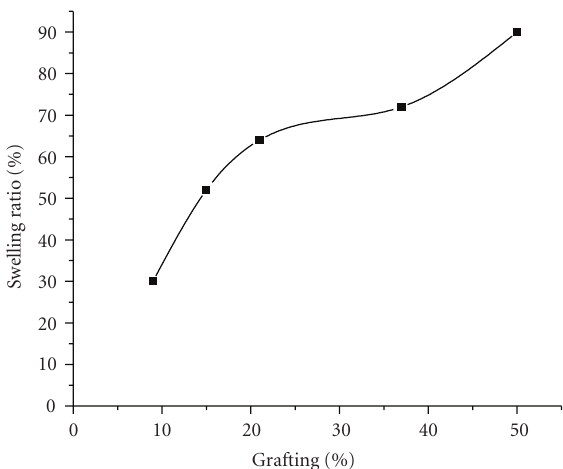
Figure 10: Swelling percentage of (IPP-g-MMA) as function of